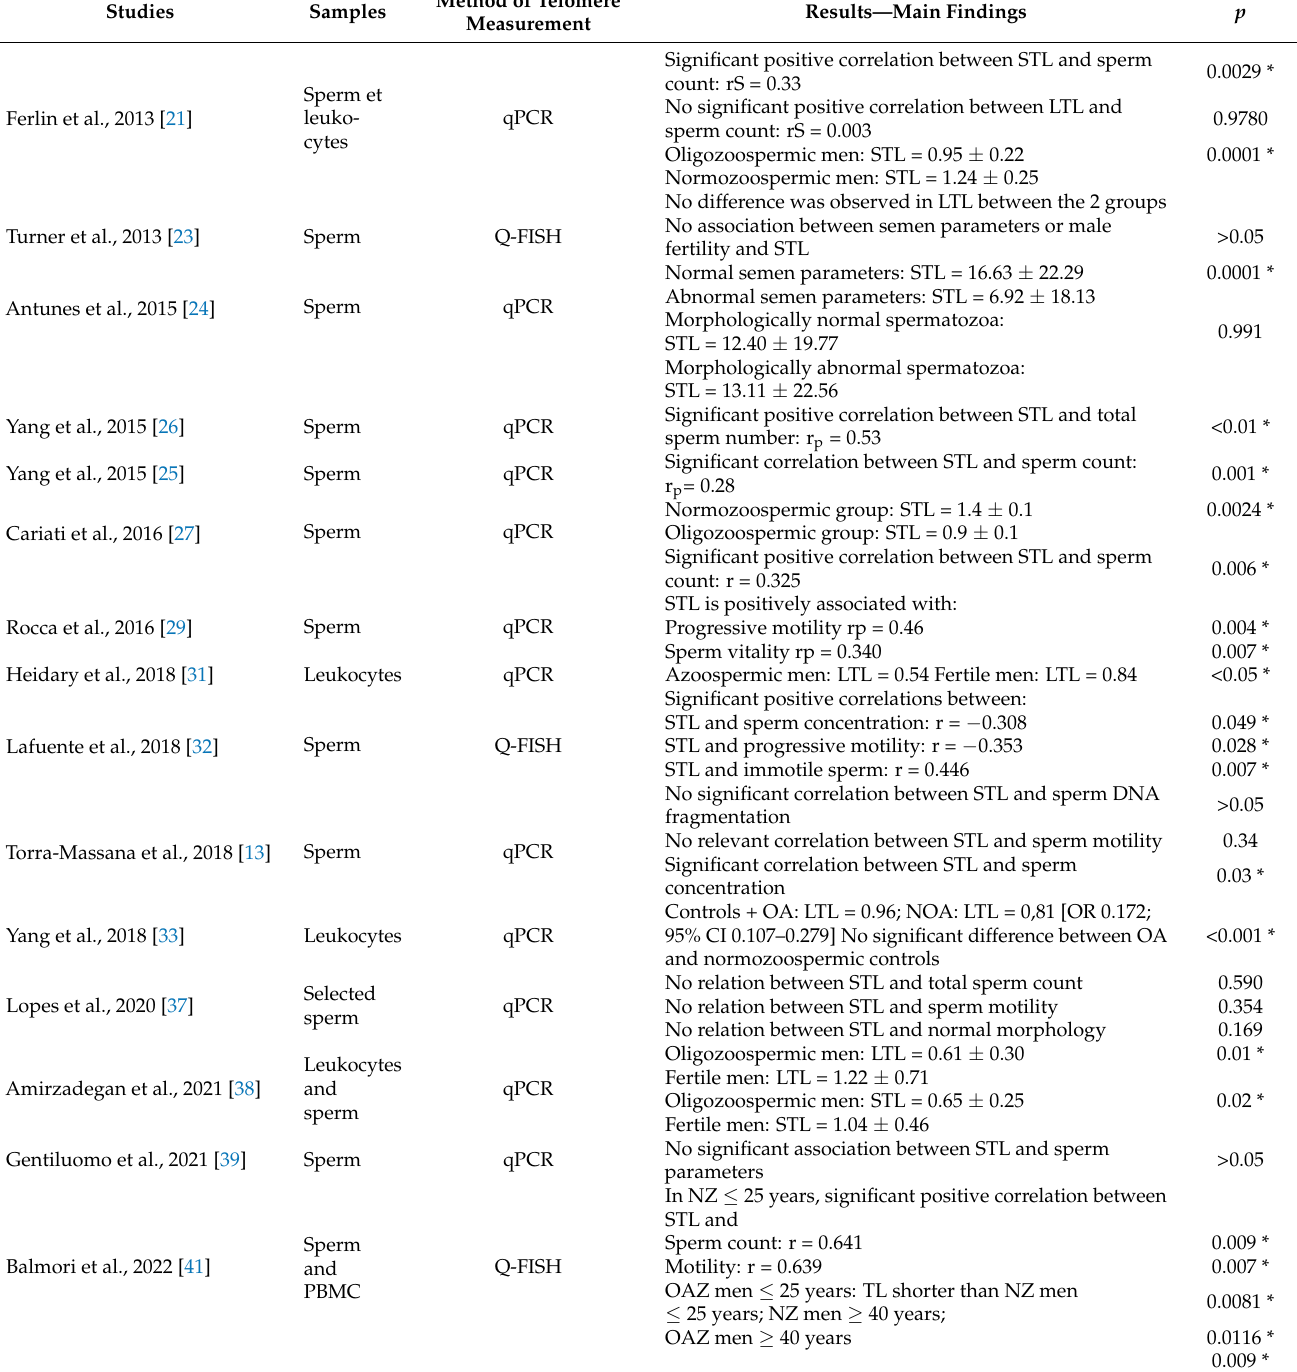
Table 2. Results for telomere length and sperm